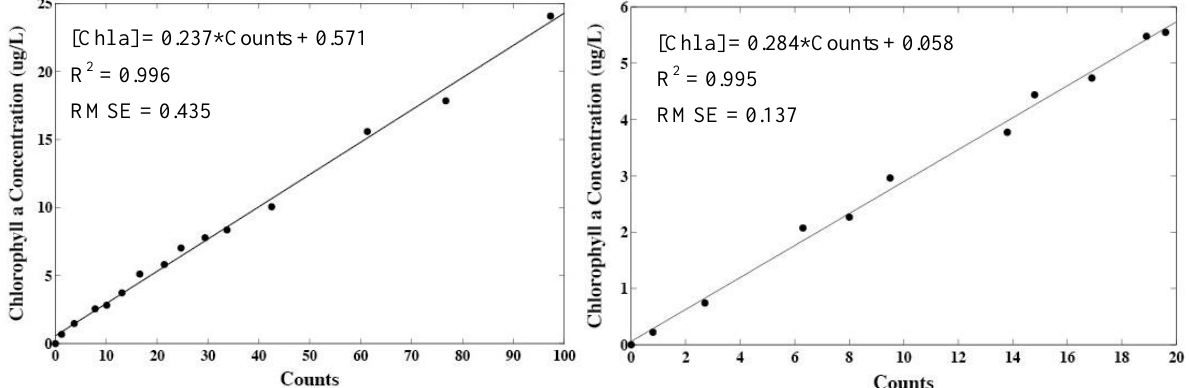
Figure 5 . Cross calibration using extracted chlorophyll a from spinach leaves ( Left ) and live Thalassiosira weissflogii cells ( Right ). Regression equation, coefficient of determination, and root mean squared error (RMSE) are included in each